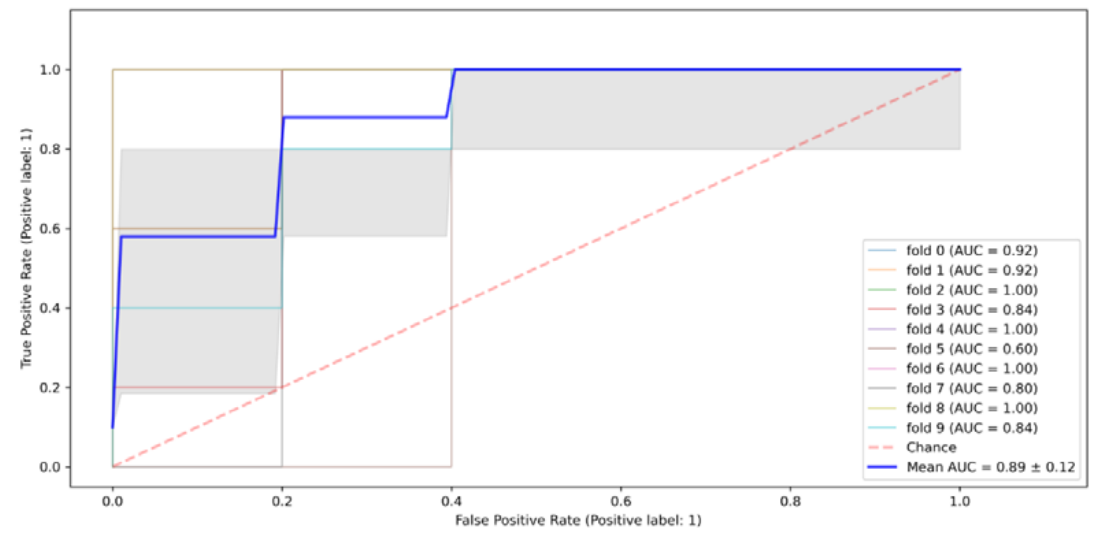
Figure 7. Gradient boosting algorithm ROC curve.